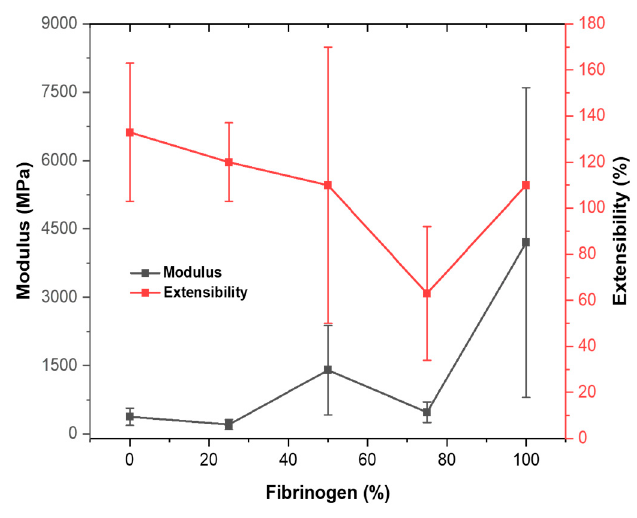
Figure 6. Extensibility and modulus of electrospun fibrinogen:PCL nanofibers at ratios of 0:100, 25:75, 50:50, 25:75 and 100:0.